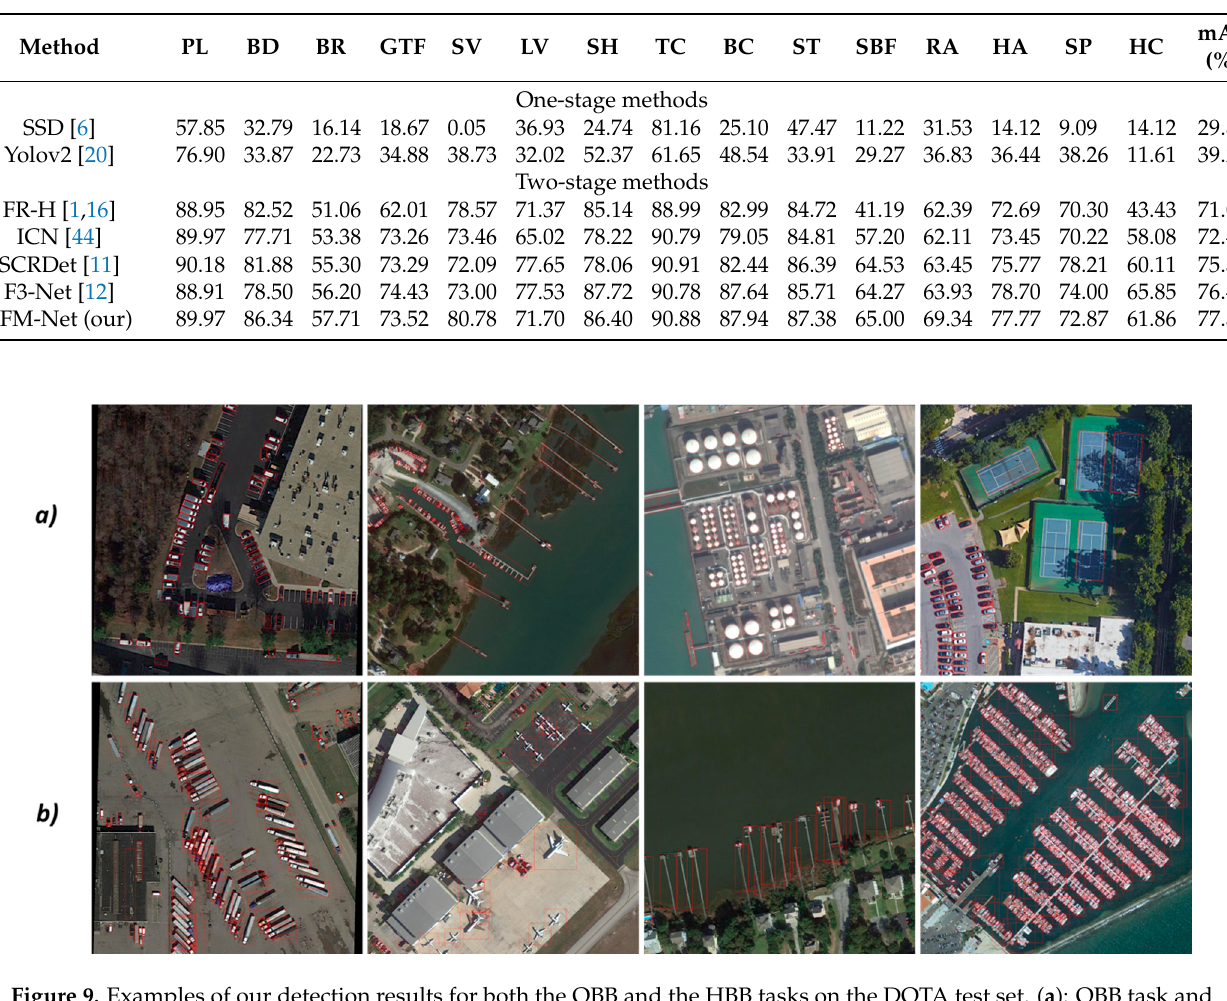
Table 3. Performance evaluation of the HBB task on the DOTA dataset.